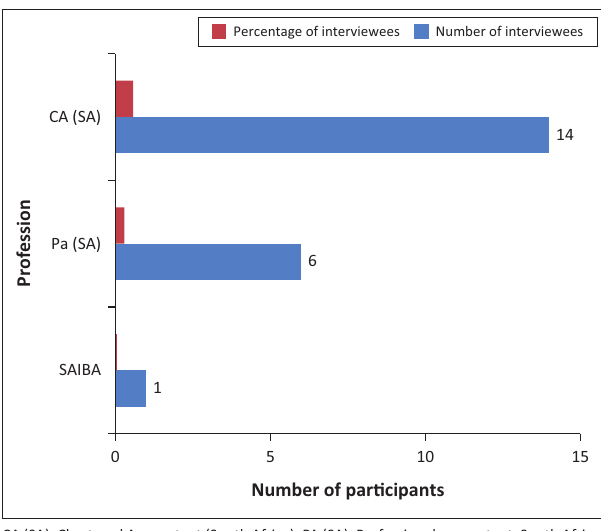
FIGURE 2: Breakdown of professional designation of